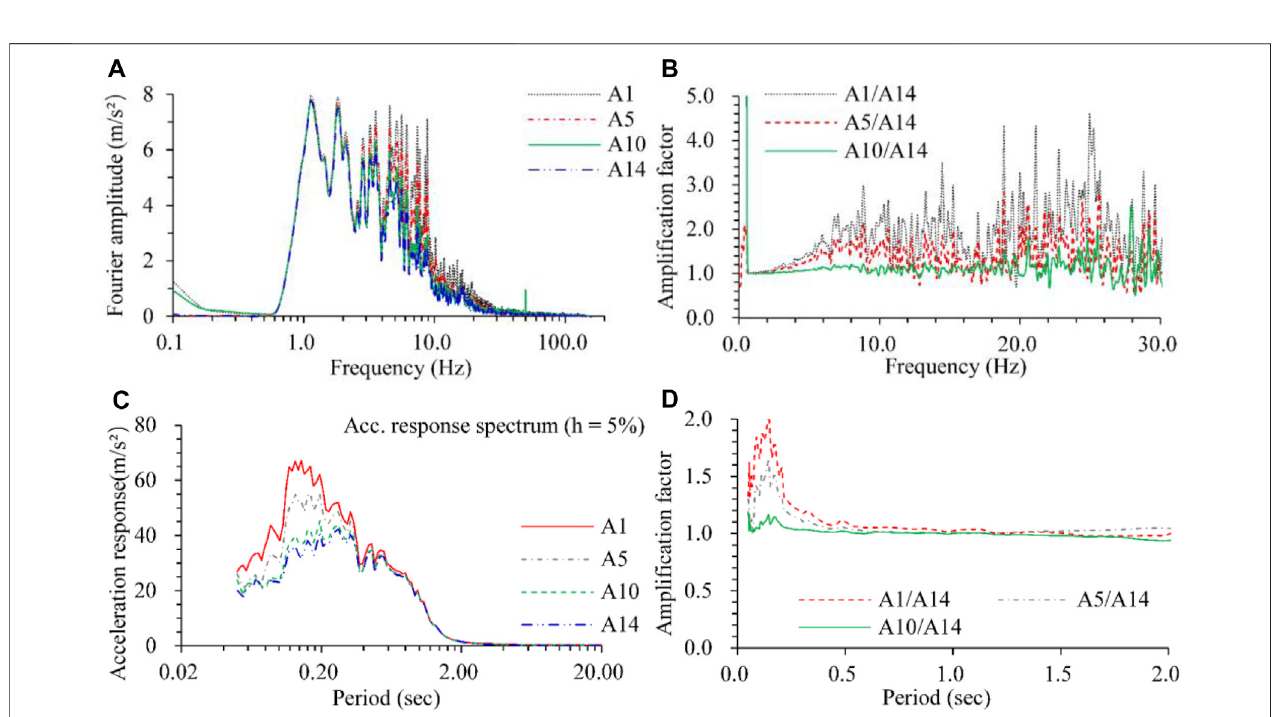
FIGURE 9 | Fourier spectrum and response spectrum at No.36 – 1.2 g. (A) Fourier spectrum of speci fi c points, (B) ampli fi cation factor of Fourier spectrum, (C) acceleration response spectrum of speci fi c points, (D) ampli fi cation factor of acceleration response spectrum.